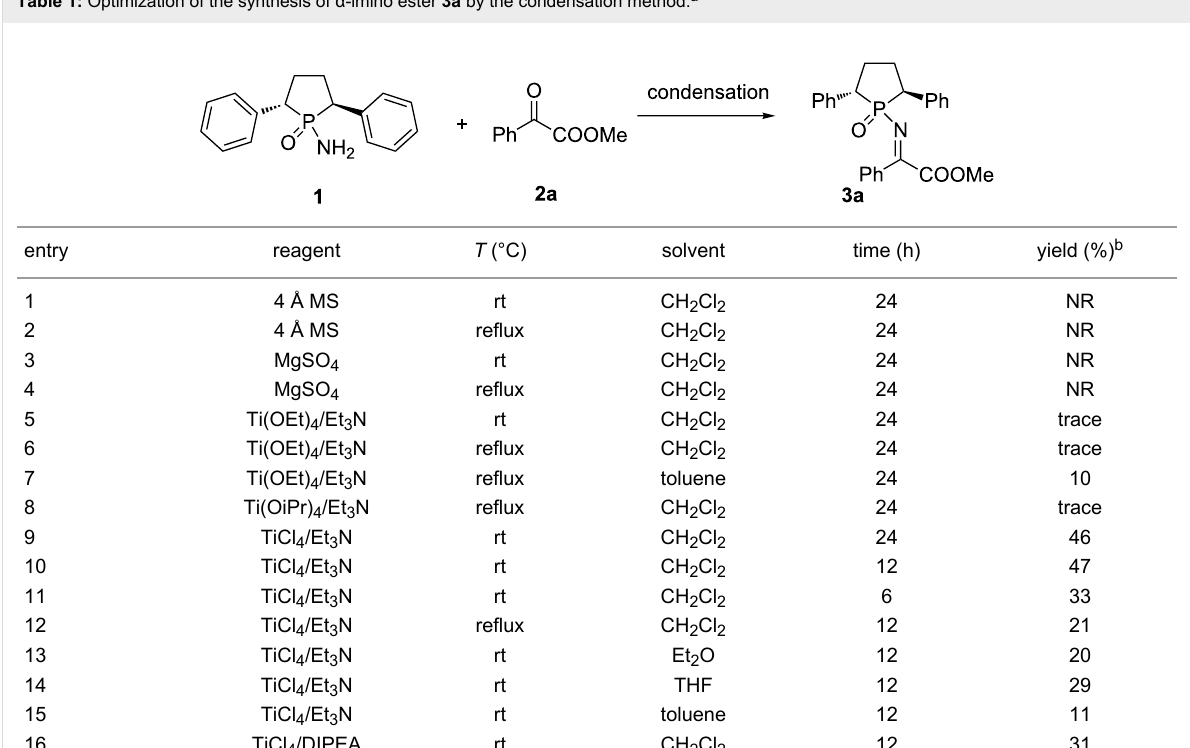
Table 1: Optimization of the synthesis of α -imino ester 3a by the condensation method. a